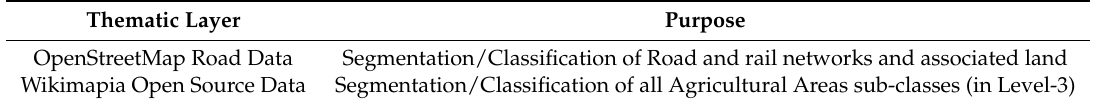
Table 3. Thematic Layers used in segmentation and classification processes.